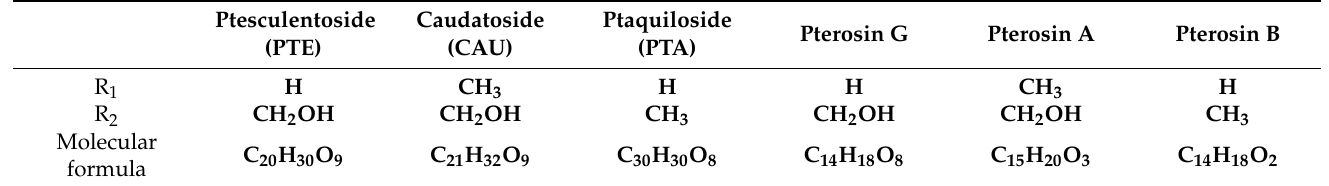
Table 1. Chemical structure of PTA derivatives (based on [19]). See also Figure 6.